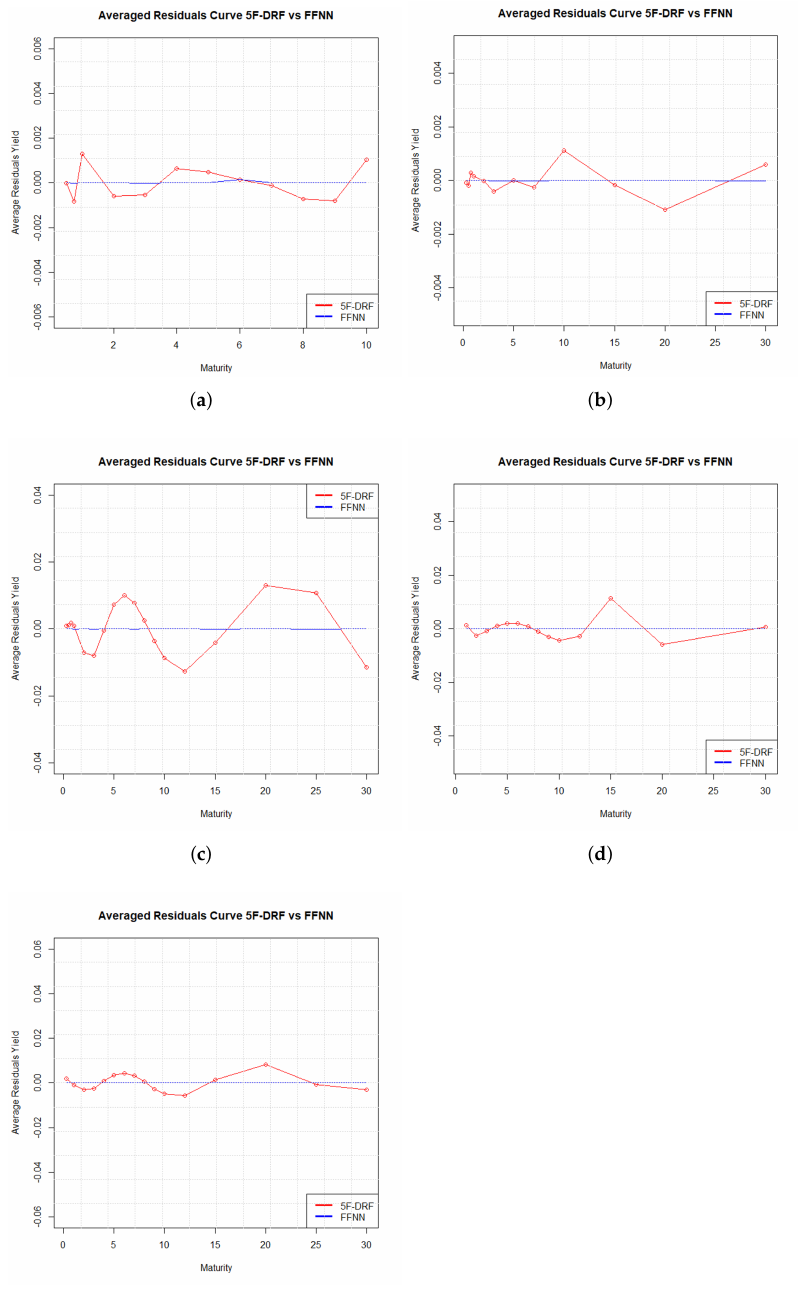
Figure 6. Average residuals generated by 5F-DRF and FFNN for Brazil ( a ), Russia ( b ), India ( c ), China ( d ), South Africa ( e